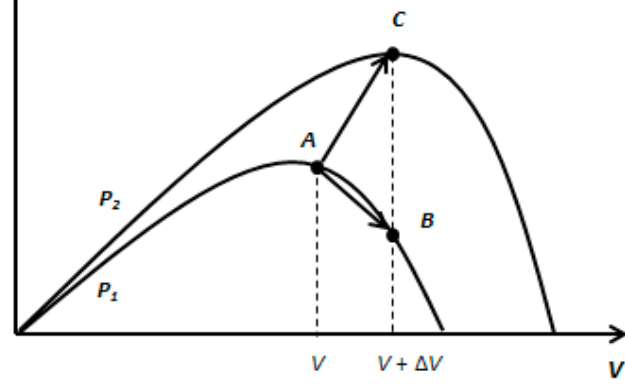
Figure 9. Typical P&O MPPT algorithm.